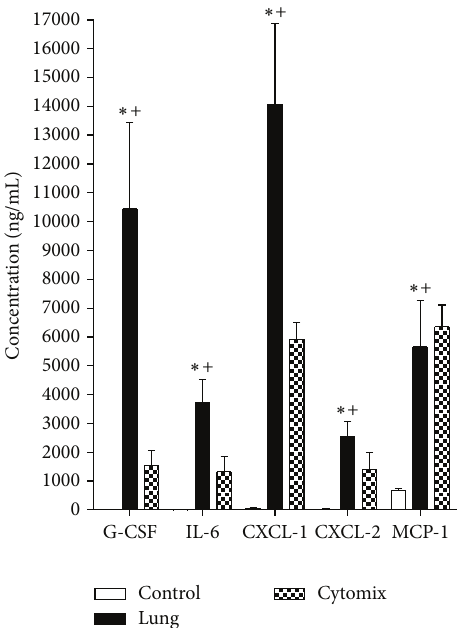
Figure 1: Absolute increase in selected cytokine concentrations in MLEC media. G-CSF, IL-6, CXCL-1, CXCL-2, and MCP-1 concen- trations from MLECs exposed to control uncirculated perfusate (open bar), lung perfusate (solid bar), and cytomix (checkered bar). ( ∗ 𝑃 < 0.05 concentration after 8 h incubation on MLEC versus concentration before incubation on MLEC (0h), + 𝑃 < 0.05 versus control perfusate after both were incubated on MLEC cultures for 8 h, ± SEM). Where open bars are not apparent (G-CSF, IL-6, CXCL- 1, CXCL-2), the increase is too small to